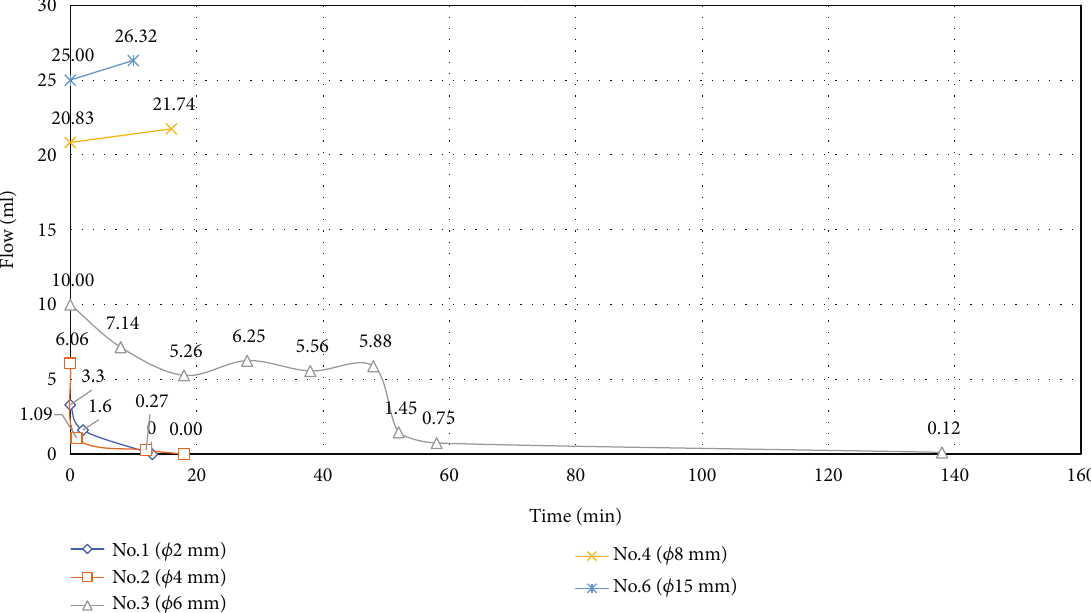
Figure 10: Flow-time relation diagram of leakage self-closed